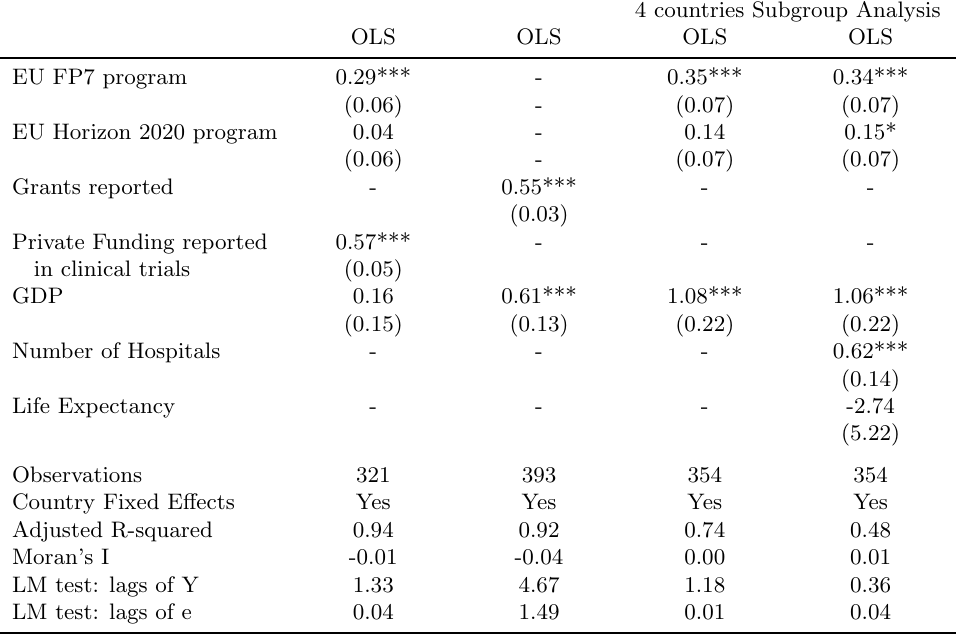
Table A.2: Estimates of (Spatial) Knowledge Production Function by